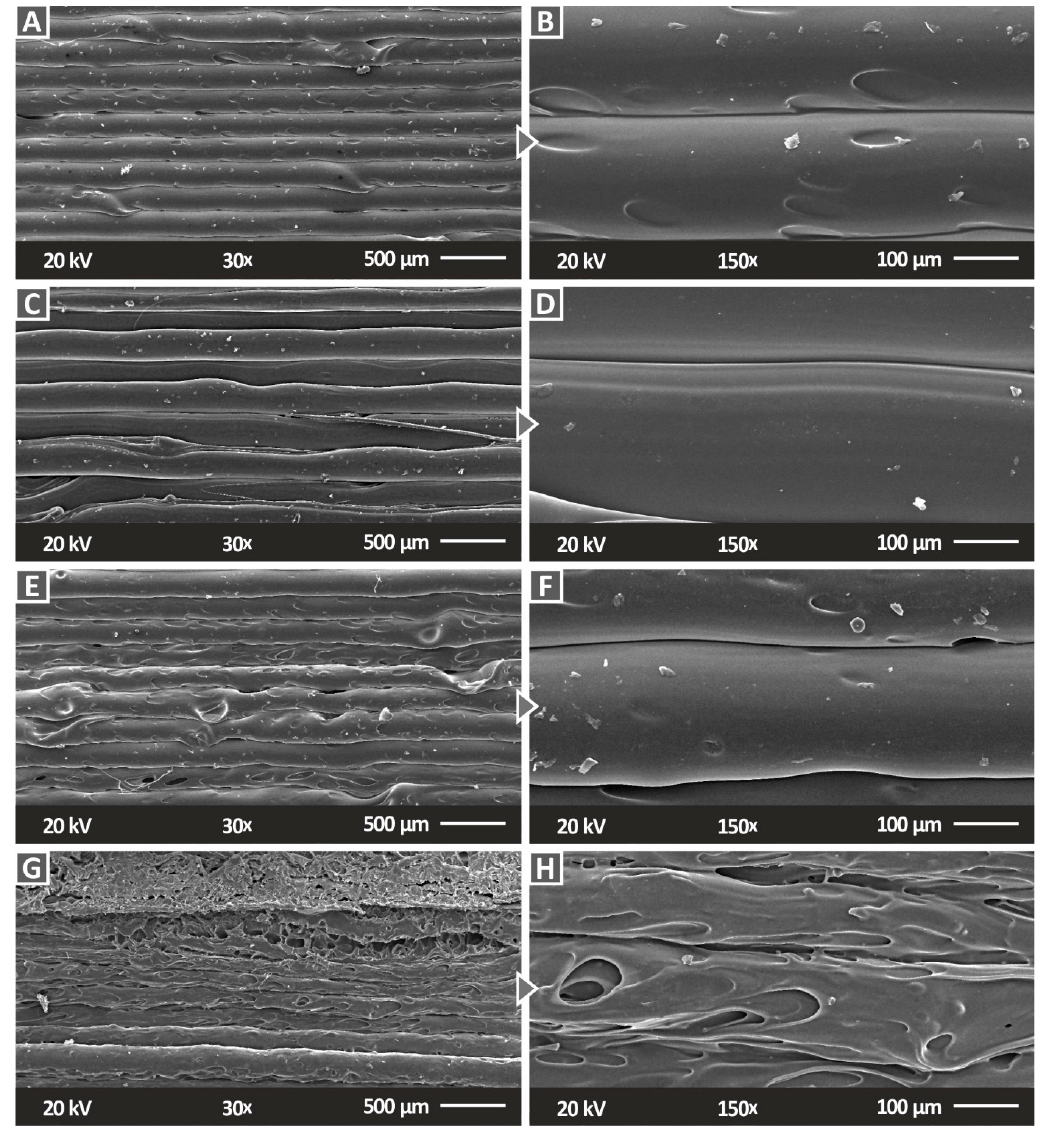
Figure 10. SEM micrographs of the side surface of the prepared PC/SiC nanocomposites: ( A ) 30× magnification, 1 wt.%, ( B ) 150× magnification, 1 wt.%, ( C ) 30× magnification, 2 wt.%, ( D ) 150× mag ‐ nification, 2 wt.%, ( E ) 30× magnification, 3 wt.%, ( F ) 150× magnification, 3 wt.%, ( G ) 30× magnifica ‐ tion, 6 wt.%, and ( H ) 150× magnification, 6 wt.%.